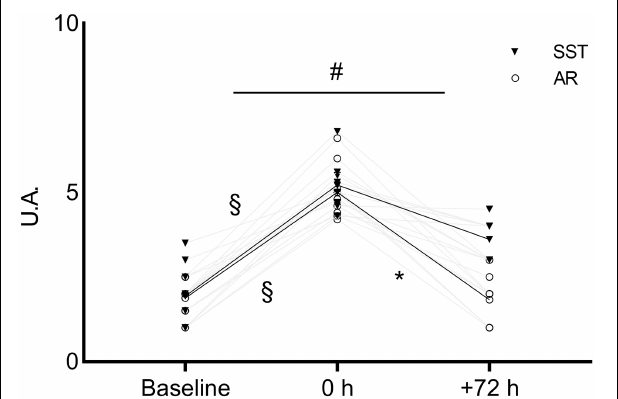
FIGURE 2 | A graphical representation of the recovery pattern of muscle soreness. The bold lines identify the means of both SST and AR. # Significant ( P < 0.05) interaction throughout the time points (baseline, 0 h and +72 h). § Significant ( P < 0.05) difference between 0 h and baseline for SST and AR. *Significant ( P < 0.05) difference between +72 h and 0 h for AR. SST, sport-specific training session; AR, active recovery session; VAS, visual analogue scale.